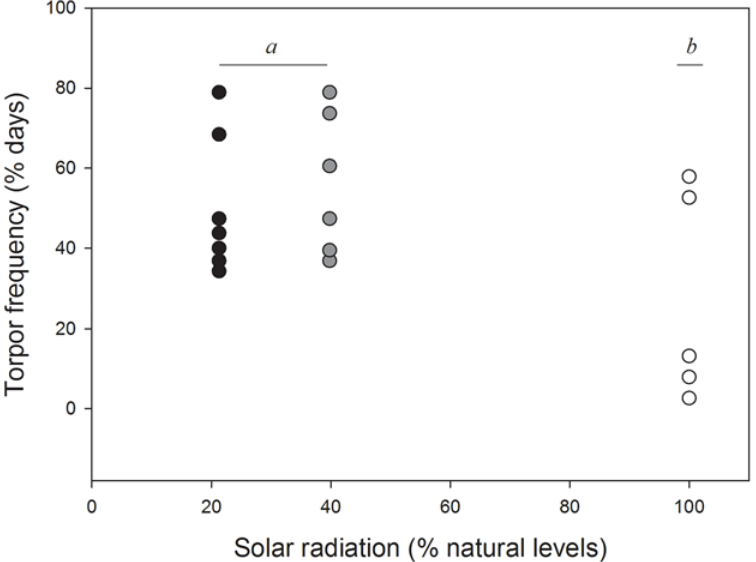
Fig 1. Frequency of torpor. Percentage of days on which torpor was expressed in eastern rock elephant shrews ( Elephantulus myurus ) housed in outdoor cages with exposure to natural (100%) or experimentally reduced (approximately 20% or 40%) levels of solar radiation. Each data point represents one